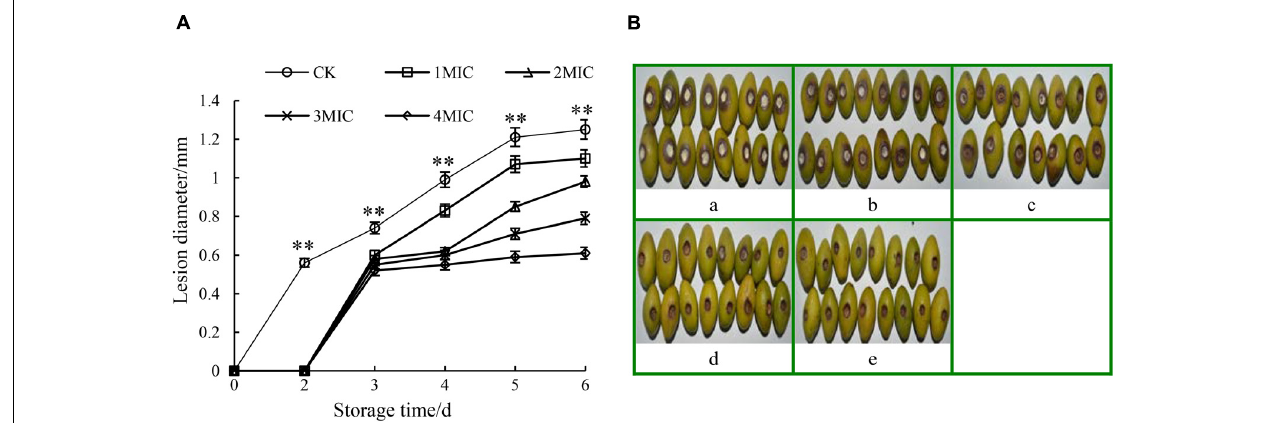
FIGURE 6 | Effects of GO treatments on the lesion diameter (A) and lesion development (B) of P. microspora -infected Chinese olive fruits. Each value is the mean for three replicates. The vertical bar indicates the standard error. Photograph of a in Figure 6B represented the treatment of propylene glycol for control. Photographs of b to e represented the treatments of GO with concentration of 1 MIC, 2 MIC, 3 MIC, 4 MIC, respectively. The vertical bar indicates the standard error. The asterisks indicate significant difference between control and GO treated fruit ( ∗∗ P <